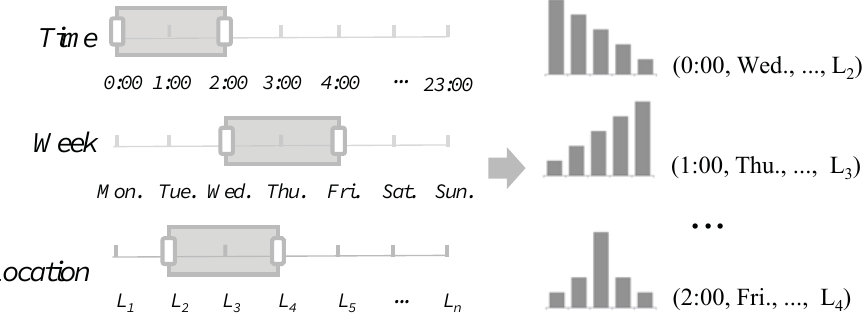
Figure 6. Examples of generating a batch of visualizations within specified attribute ranges.